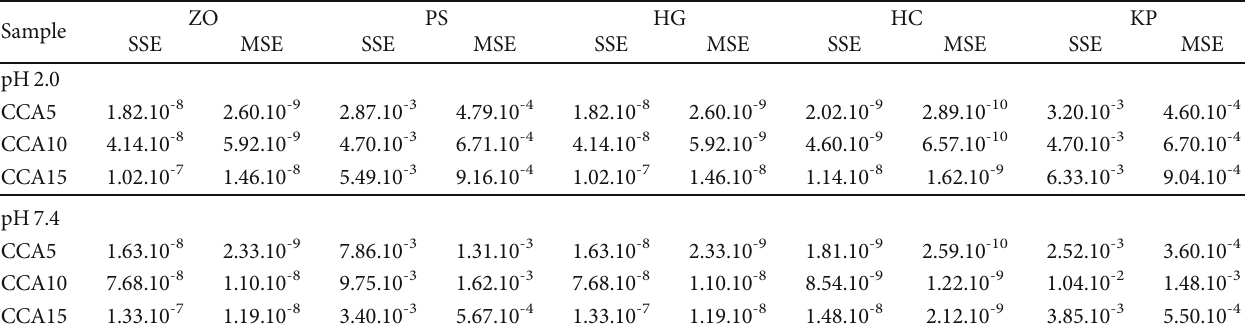
Table 3: SSE and MSE of kinetic models re fl ecting the release process of allopurinol from CCA biocomposite fi lms to pH 2.0 and pH7.4